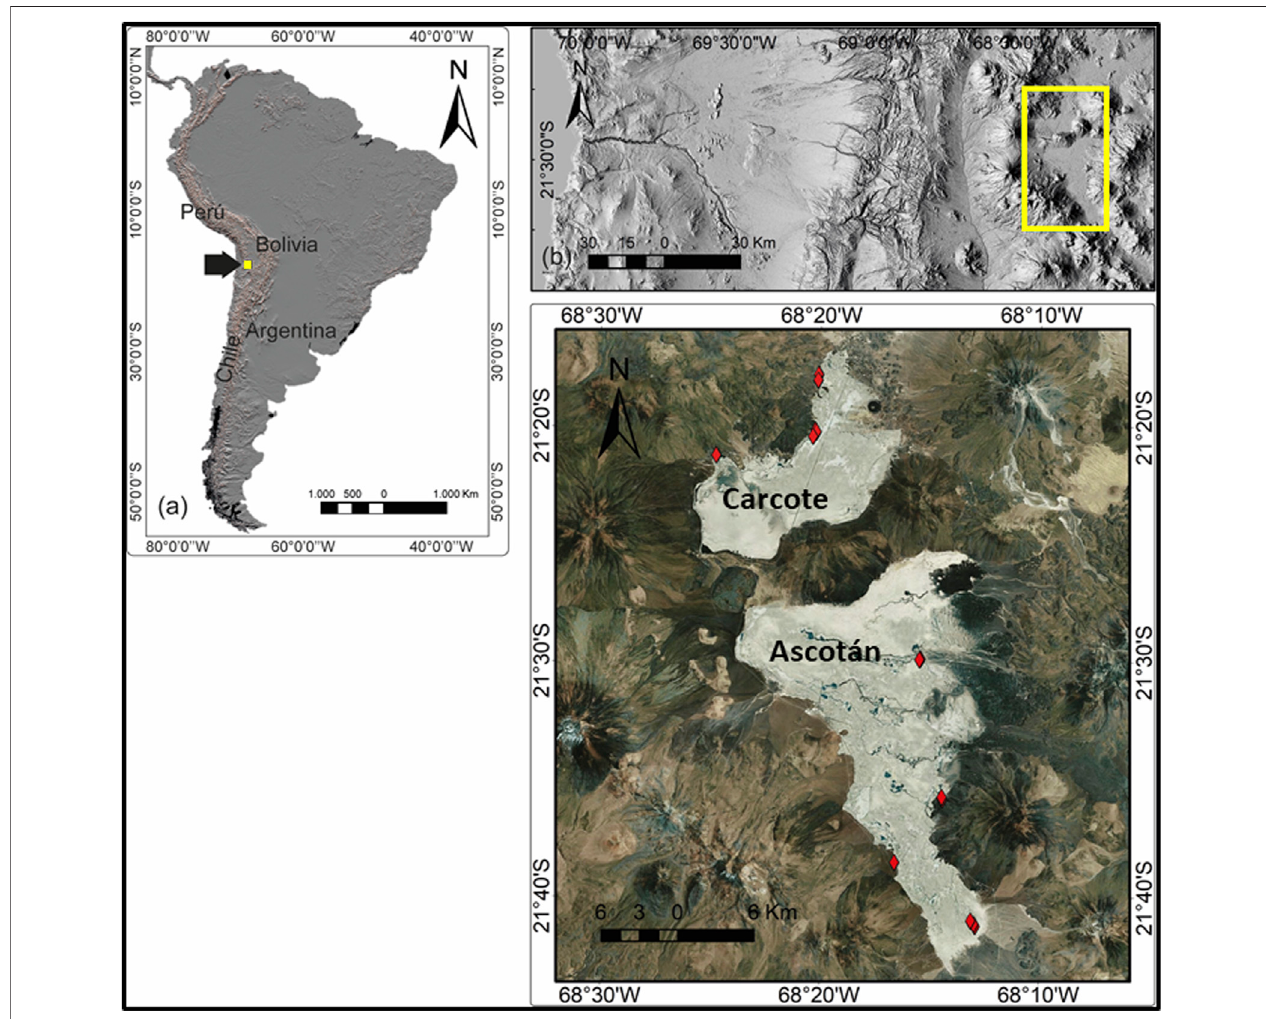
FIGURE 1 | Location of the Carcote and Ascotán salt fl ats in the Altiplano area in Chile and sampling sites distributed therein. The red points represent the speci fi c sampling areas within each salt fl at, there being nine sampling sites in the Ascotán and eight sites in the Carcote salt fl at.